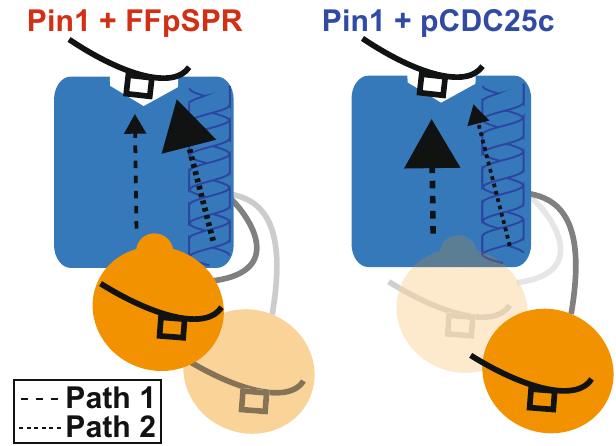
Fig. 5 | Proposed model of ligand-dependent conformational changes in Pin1. FFpSPR and pCDC25c ligands (black) activate an interdomain allosteric pathway (Path 1) in Pin1 across the main interface between the WW (orange) and PPIase domains(blue).BindingofFFpSPRmakesuseofasecondpathway(Path2)viahelix 1 in the PPIase domain. Binding of pCDC25c decreases the population of the compactstateofPin1,increases thepopulationoftheextendedstateand doesnot measurably activate Path